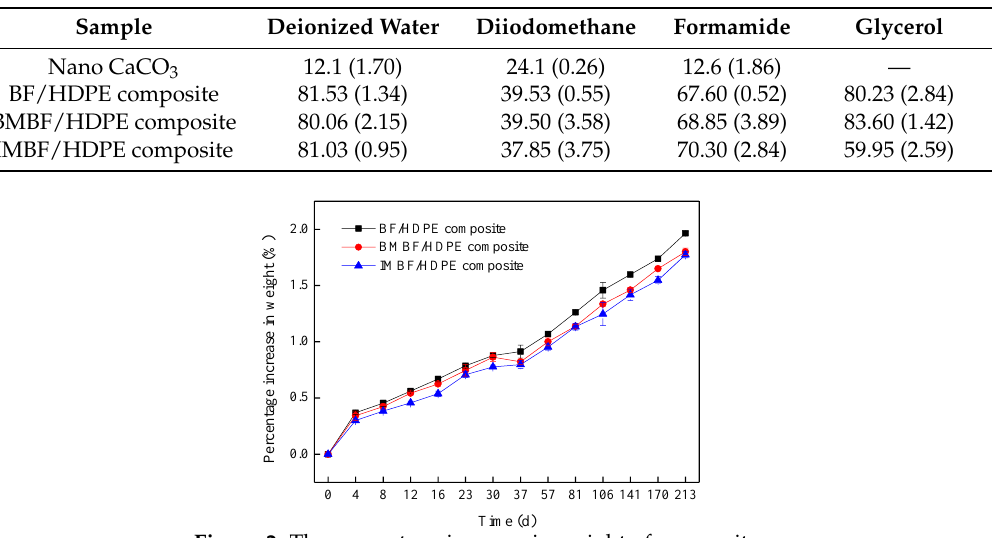
Figure 2. The percentage increase in weight of composites.